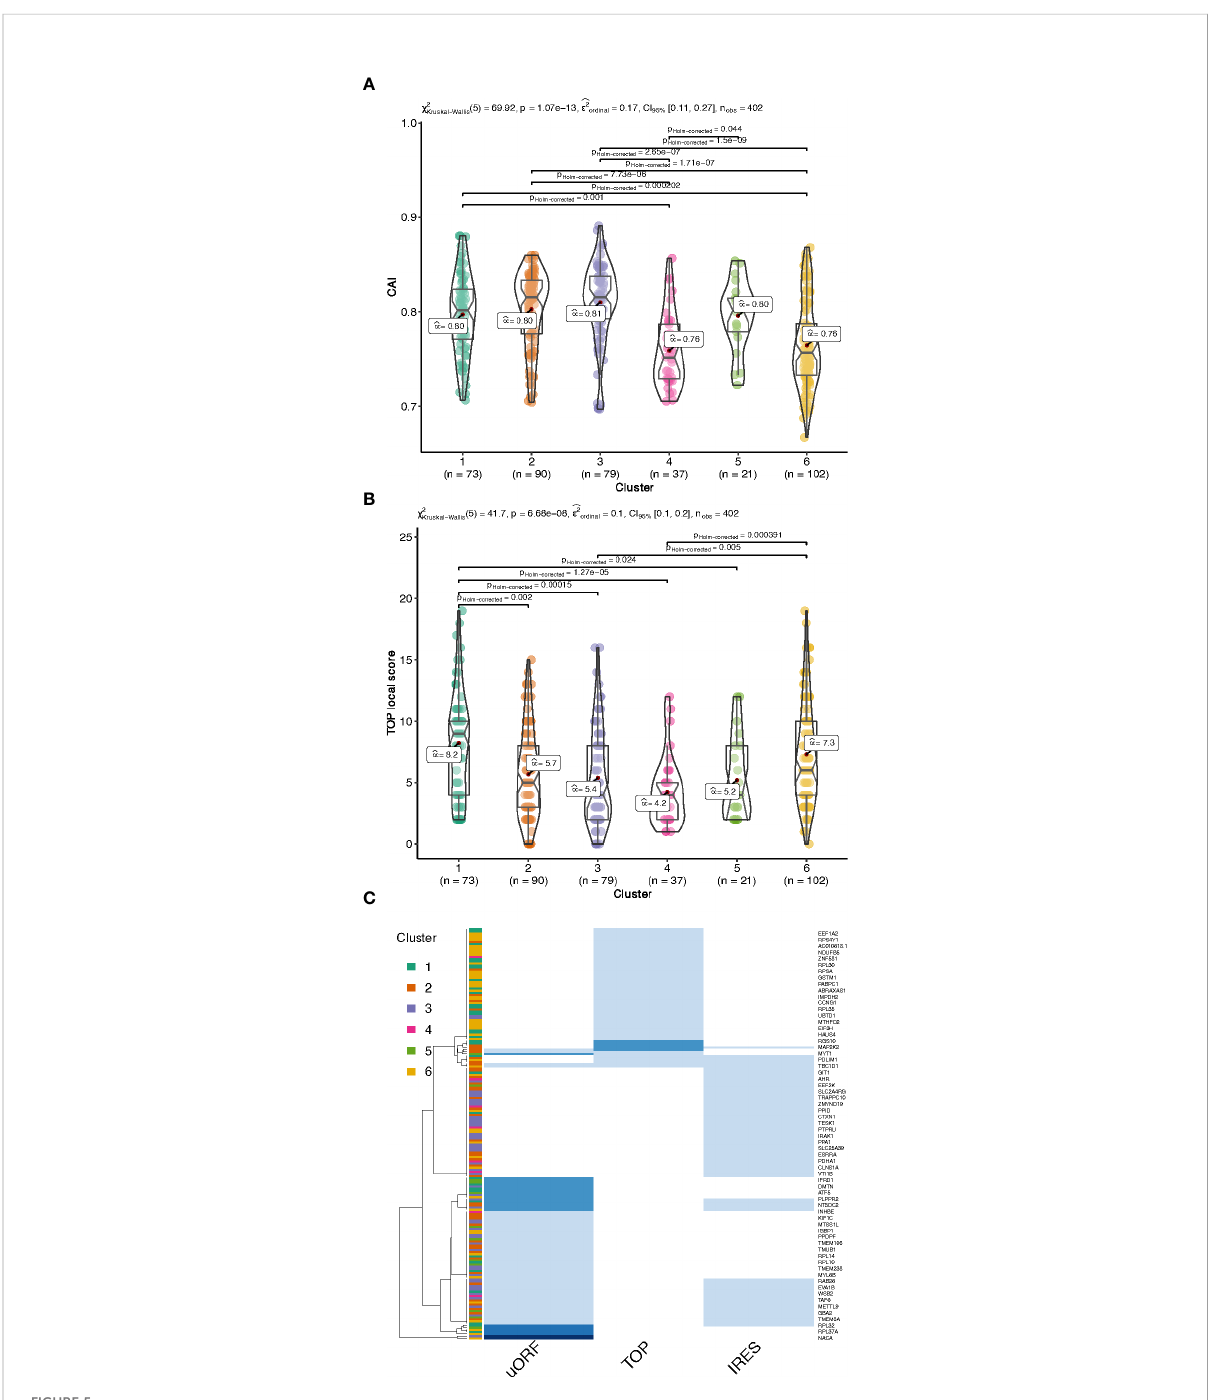
FIGURE 5 Codon Adaptation Index (CAI, A ) and functional motifs analysis of the UTRs by interrogating the UTRdb for TOP motifs (B) , and TOP, uORF and IRES in the 5 ’ UTRs (C) , common gene names of the encoding gene of each transcript are indicated on the right side. The darker the blue, the higher the number of features per RNA (from 1 to 3 per